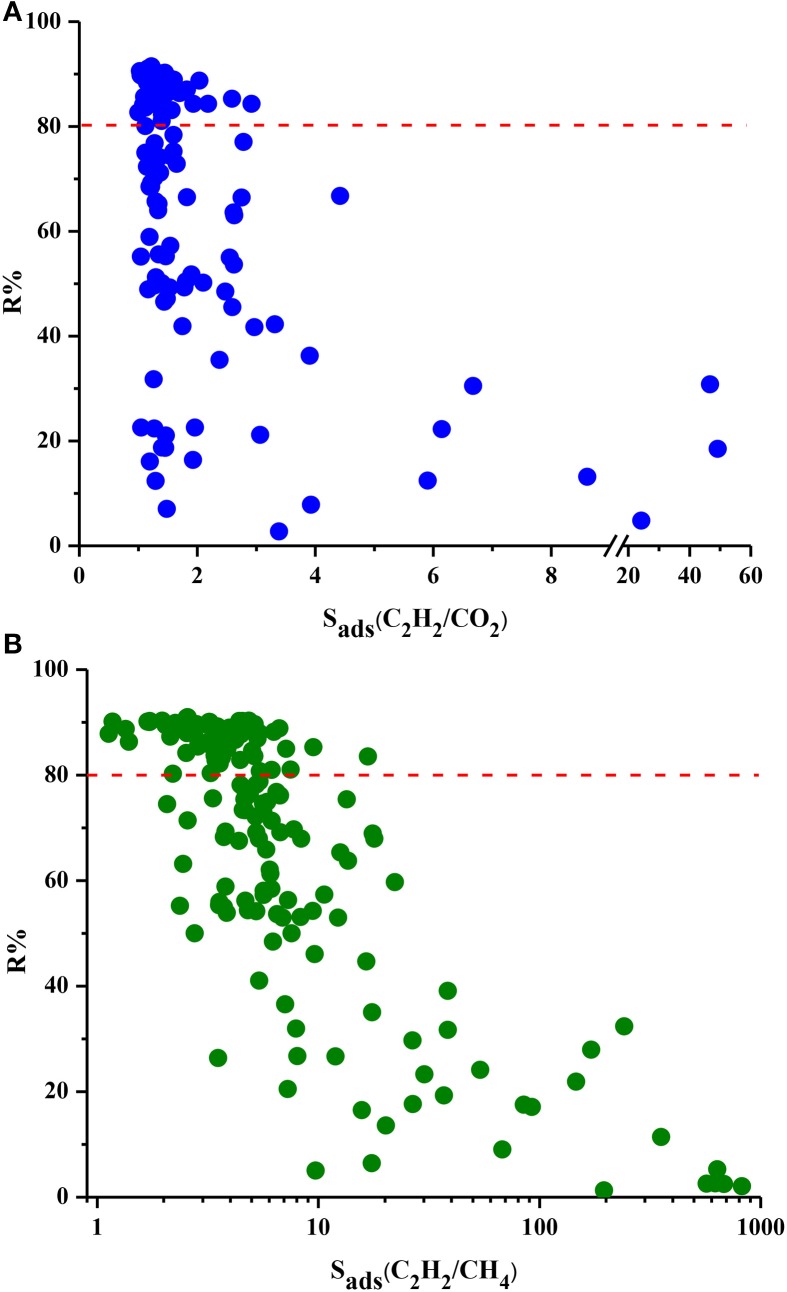
R% and Sads of MOFs for (A) C2H2/CO2 and (B) C2H2/CH4 mixtures.